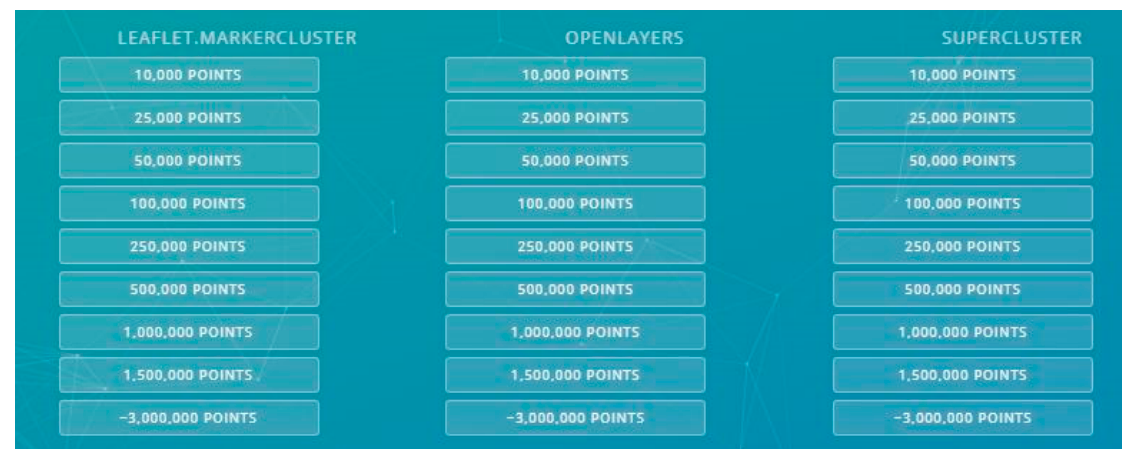
Figure 1. Web application provides all samples for clustering (5 × 9) and heatmaps (2 ×